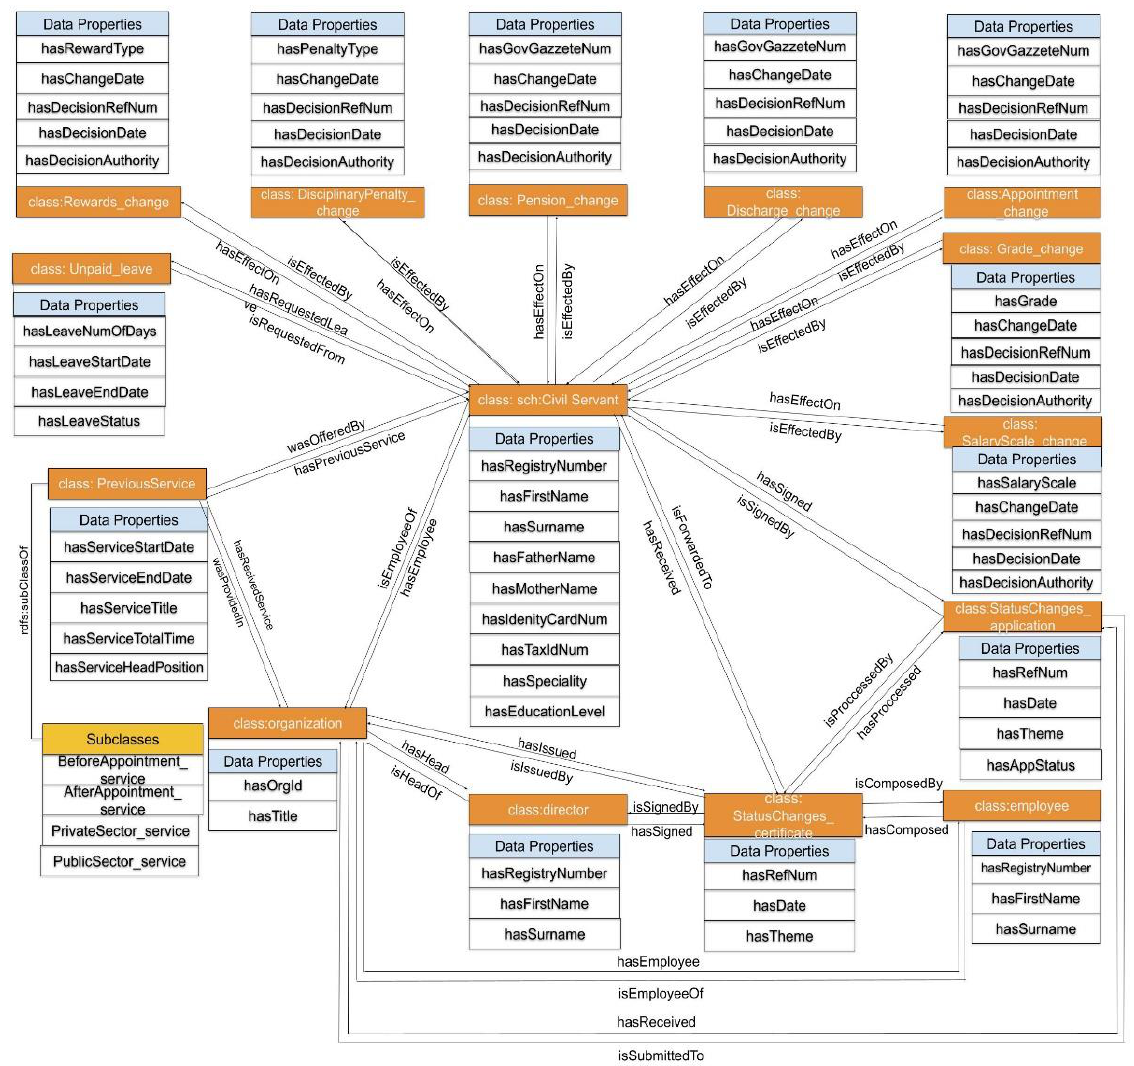
Figure 6. Classes, Object and Data Properties involved in issuing the Certificate of Employee’s Status Changes.